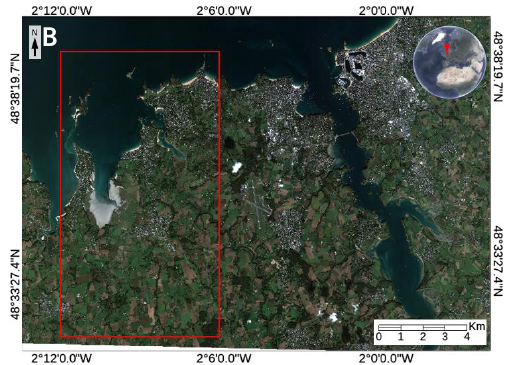
Figure 1. Natural-coloured Pleiades-1A imageries of the entire scene, taken on October 22, 2019, over the Rance river and a part of the Côte d’Emeraude (Brittany, France); (A) Image #1 taken with 18.04° incidence angle; (B) Image #2 taken with 18.95° incidence angle. Red rectangle represents the study